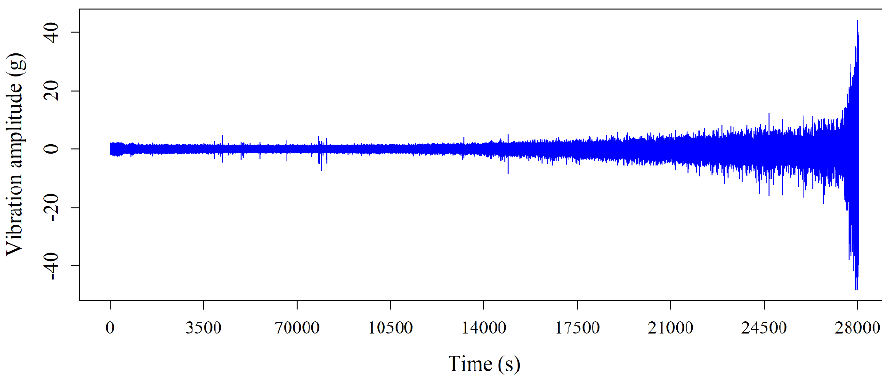
Figure 5. Vibration raw signal of bearing1_1.